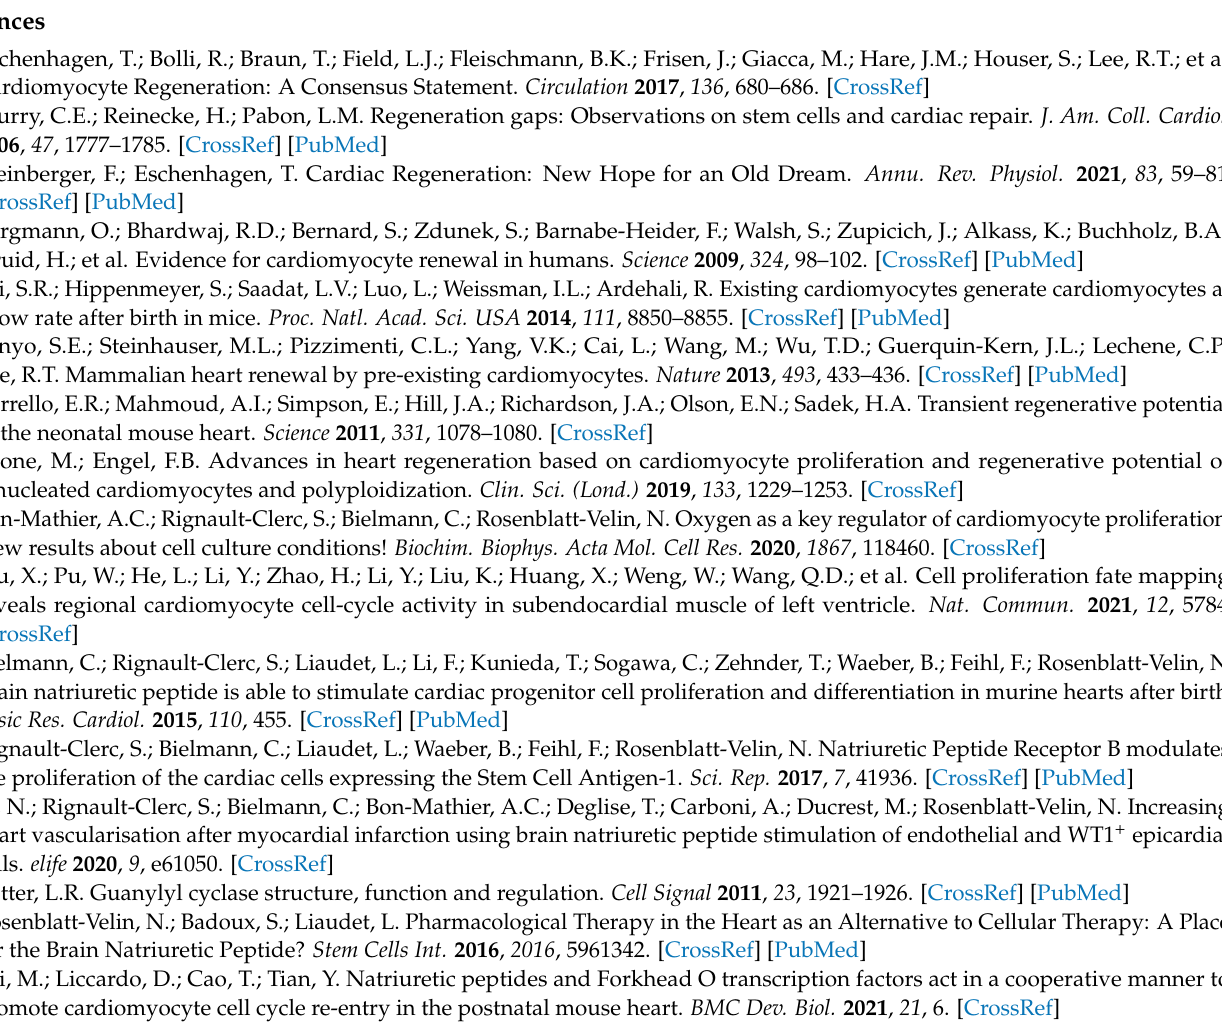
ocytes. Supplemental Figure S4. BNP treatment increases the number of neonatal cardiomyocytes in vitro. A. Supplemental Figure S5. Examples of total protein stainings of membranes used to measure pERK, ERK, pAkt and Akt levels in adult CMs stimulated in vitro with BNP (A) or in adult CMs isolated from treated mice (B). Supplementary File S1: Antibodies used in flow cytometry analysis, immunohistology and western blot analysis. Supplementary File S2: List of primers used in